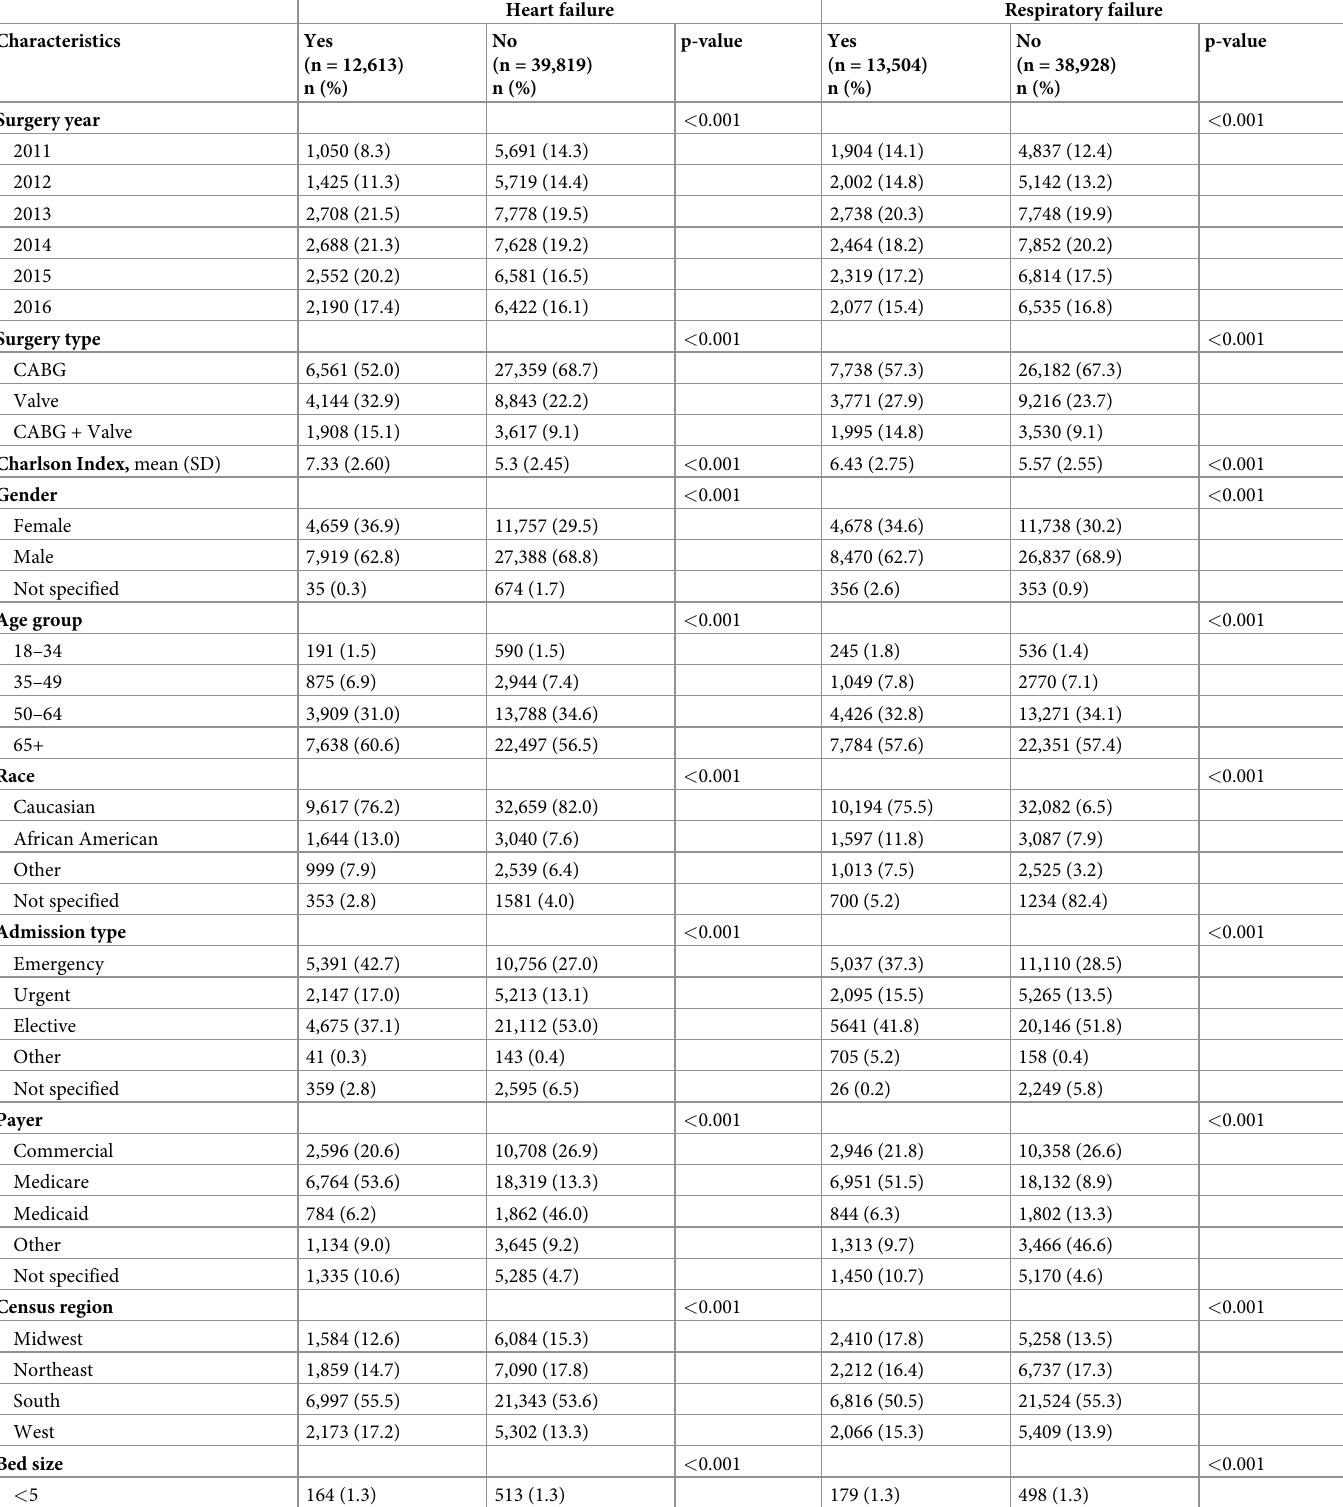
Table 1. Patient and hospital baseline demographics � of the index visit cohort. Heart failure Respiratory